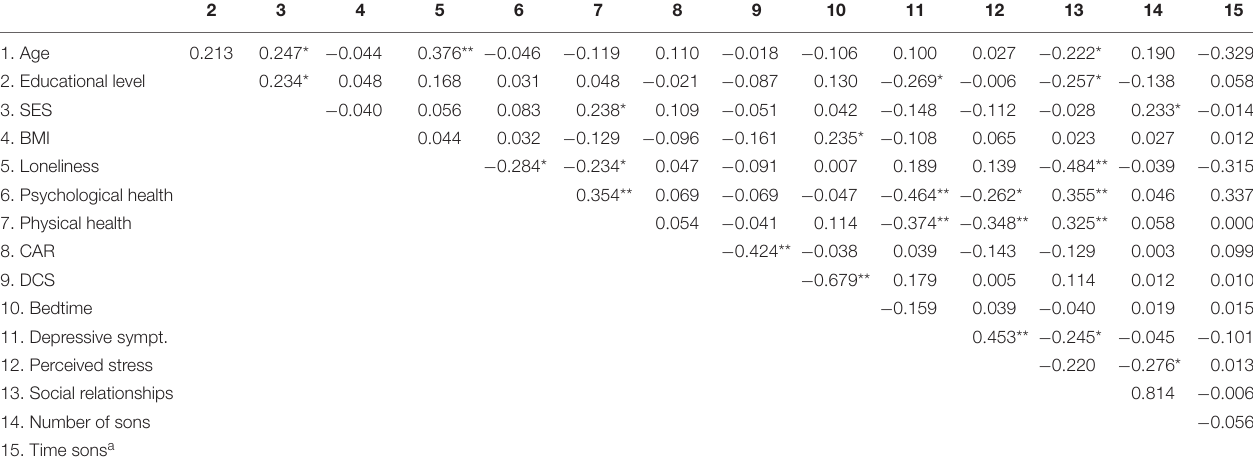
TABLE 2 | Pearson’s correlations.